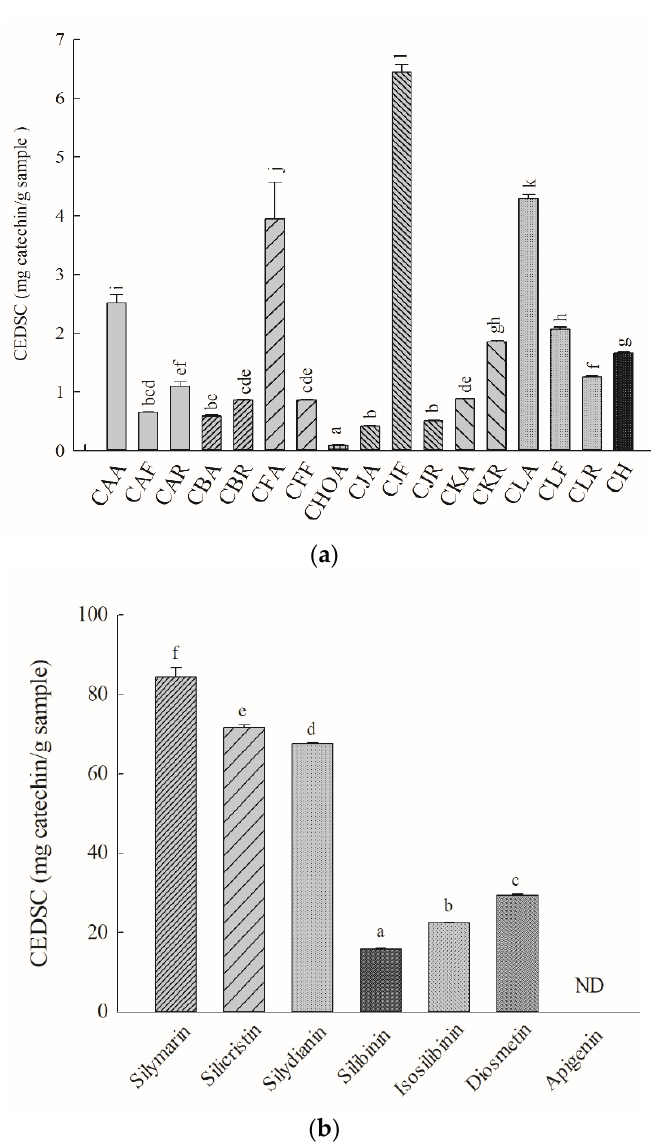
Figure 3. DPPH scavenging activities of the methanolic standardized extracts of Cirsium species and Cirsii Herb. ( a ) The methanolic standardized extracts of Cirsium species and CH; ( b ) all ingredients of the methanolic standardized extracts of Cirsium species and CH. Data are expressed as means ± SD (n = 3). ND: non-detected. CAA, the aerial part of C. arisanense ; CAF, the flower part of C. arisanense ; CAR, the radix part of C. arisanense ; CBA, the aerial part of C. brevicaule ; CBR, the radix part of C. brevicaule ; CEDSC. catechin equivalent of DPPH scavenging capacity; CFA, the aerial part of C. ferum ; CFF, the flower part of C. ferum ; CHOA, the aerial part of C. hosokawae ; CJA, the aerial part of Cirsium japonicum DC. var. australe ; CJF, the flower part of C. japonicum DC. var. australe ; CJR, the radix part of C. japonicum DC. var. australe ; CKA, the aerial part of C. kawakamii ; CKR, the radix part of C. kawakamii ; CLA, the aerial part of C. lineare ; CLF, the flower part of C. lineare ; CLR, the radix part of C. lineare ; CH, Cirsii Herb; DPPH, 1,1-diphenyl-2-picrylhydrazyl. Bars with different letters indicate statistical significances, p < 0.05.